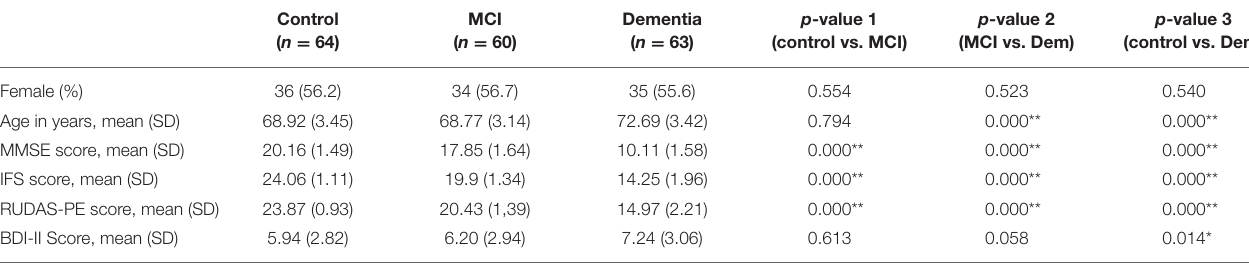
TABLE 1 | Demographic characteristics and brief cognitive test performance according to study groups.